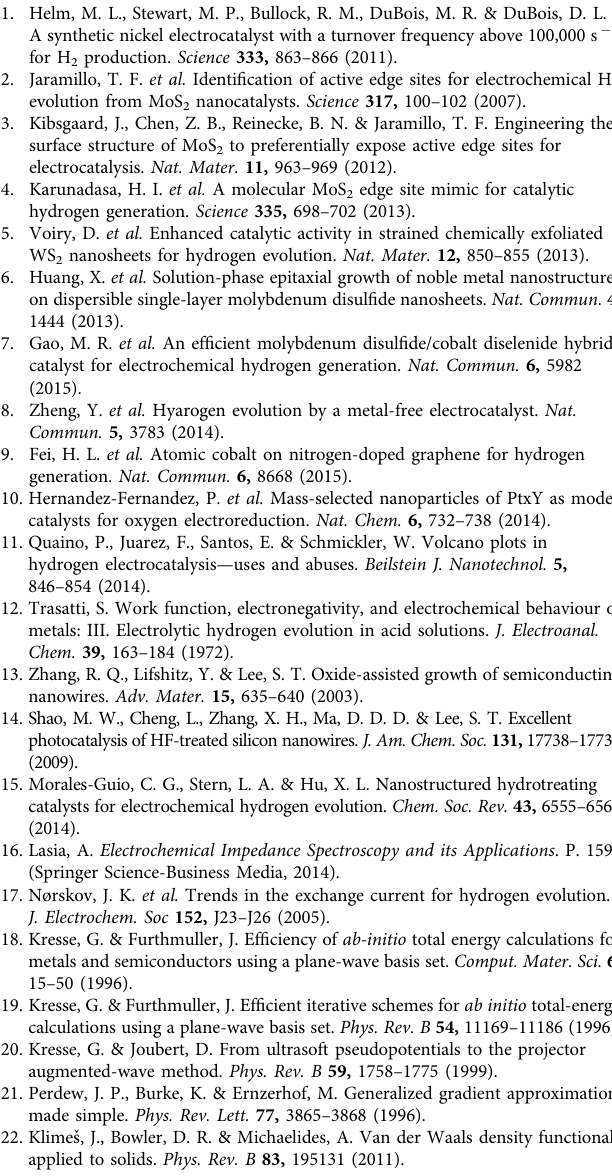
Data availability . All relevant data are available on request, which should be addressed to